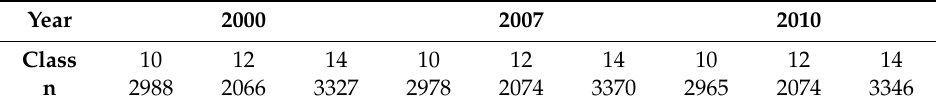
Table 1. Number of samples (n) of all the variables (gross primary production (GPP), Nitrogen (N) deposition, temperature, precipitation, and sunshine). Class 10: Grasslands, Class 12: Croplands, and Class 14: Croplands / natural vegetation